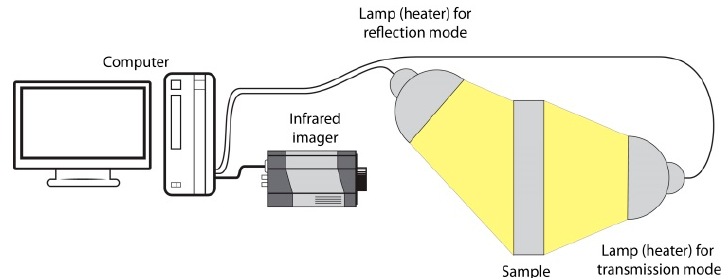
Figure 1. Basic thermographic setup scheme.